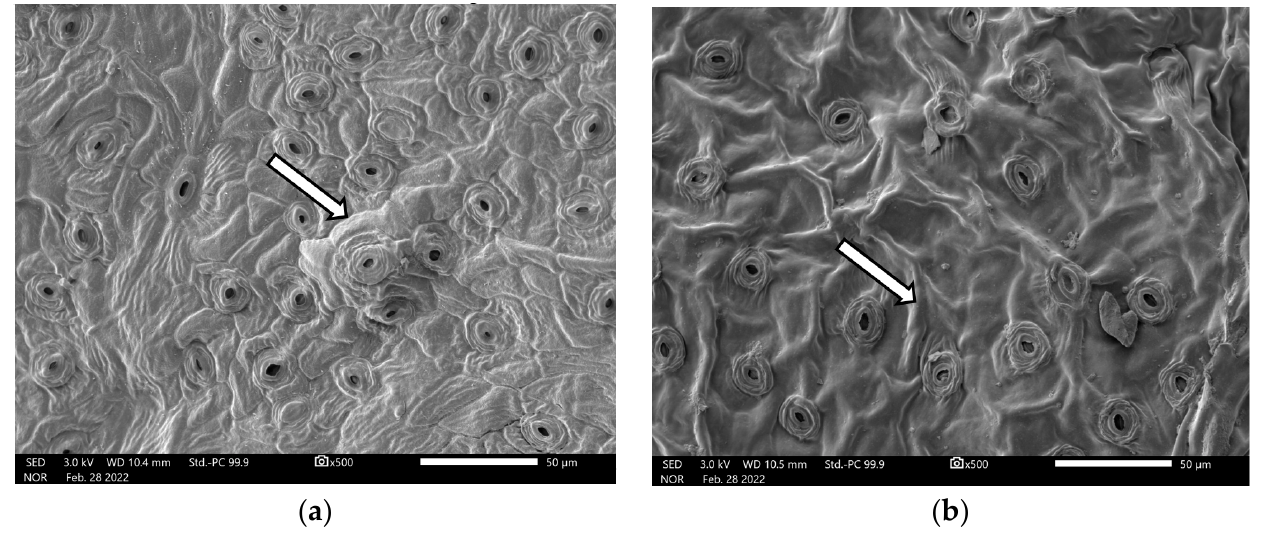
Figure 3. Comparative scanning electron microscope (SEM) imagery of abaxial laminar surfaces of separate specimens of ( a ) S. reclinatum subsp. austrofloridense and ( b ) S. reclinatum subsp. reclinatum . Note the specimens on the left display distinct epidermal cell outlines marked by impressed grooves (arrows), and that specimens on the right display less-distinct cell outlines and exhibit ridges that lack impressed grooves (arrows). See Supplementary Materials for digital microscopy images.